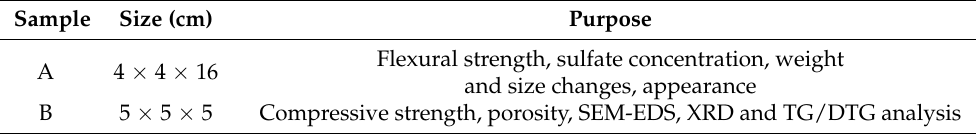
Table 3. Sizes and purposes of the samples.